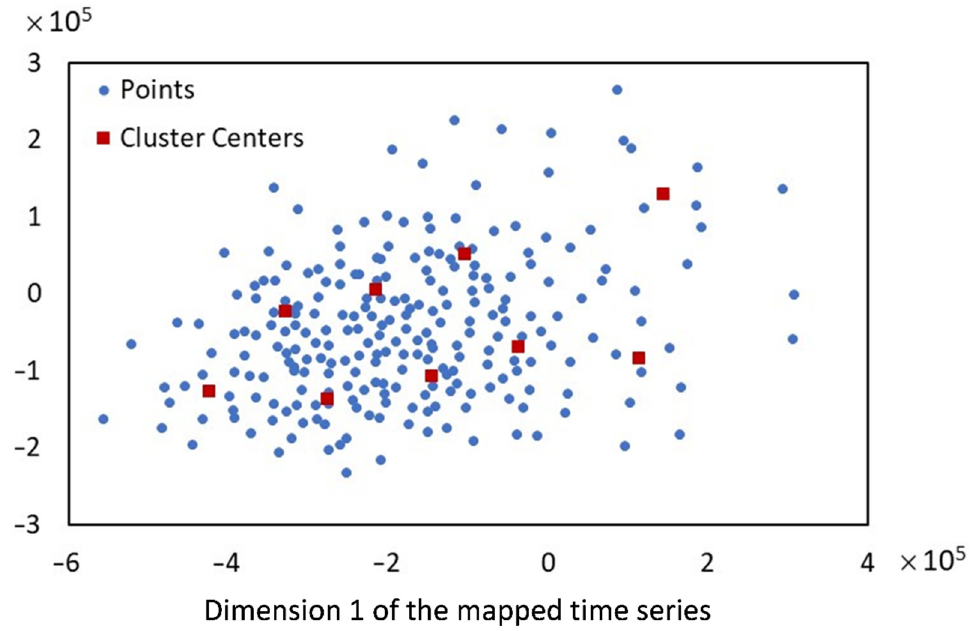
Figure 6. Results of the multidimensional scaling and the optimal fuzzy clustering. Blue dots represent the two-dimensional points to which the 245 time series are mapped through the multidimensional scaling process. Red rectangles represent the position of the nine optimal cluster center positions obtained by the optimal fuzzy clustering. Axes are dimensionless.